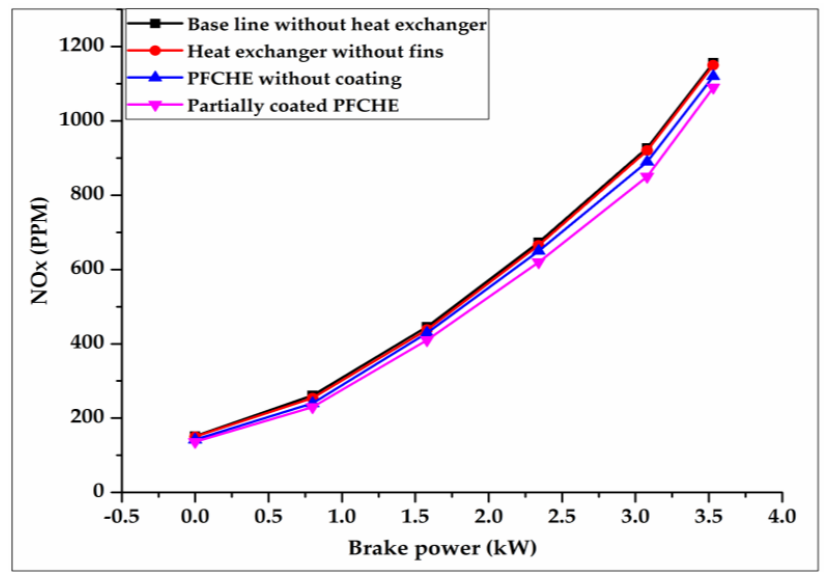
Figure 11. Effect of heat exchanger on NO x emission.